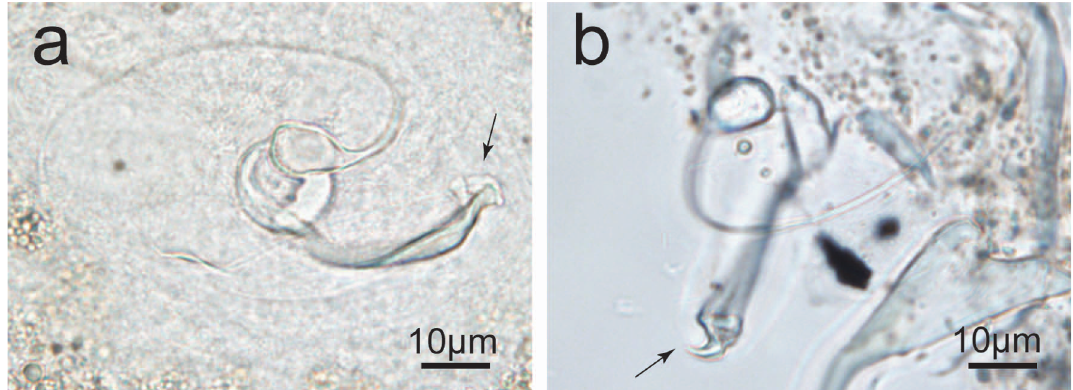
Figure 8. Morphology of the male copulatory complex of the same specimen of Cichlidogyrus cirratus observed in different angles. (a) undigested C. cirratus , (b) digested C. cirratus